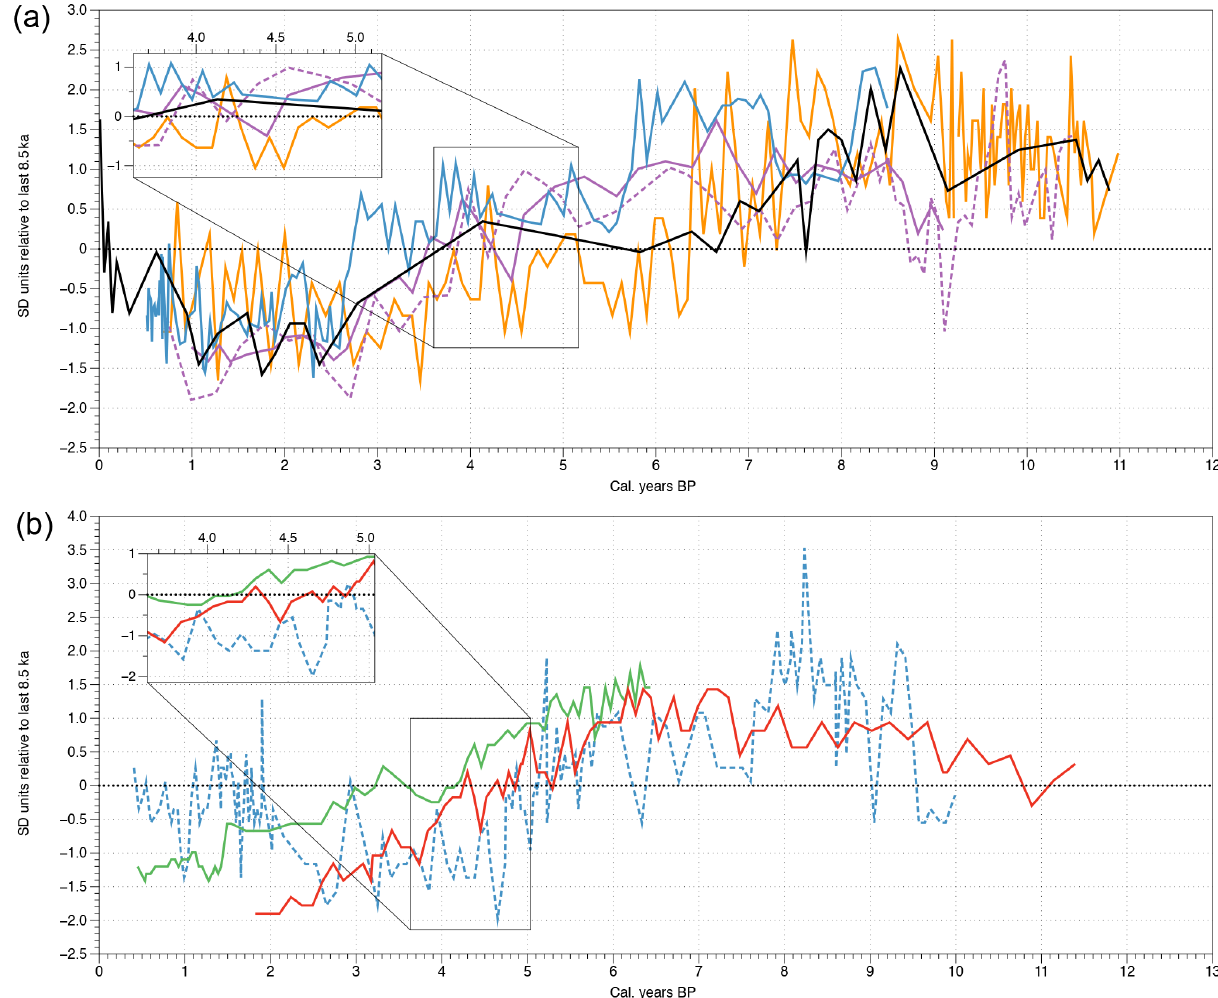
Figure 2. Alkenone-based paleo SST estimates from North Atlantic sites (shown in Fig. 1). (1) Black – Risebrobakken et al. (2010): core PSh-5159N; 71.35 ◦ N, 22.63 ◦ E. (2) Purple – Marchal et al. (2002): core M23258-2; 75 ◦ N, 13.97 ◦ E. (3) Dashed purple – Rigual-Hernández et al. (2017): core SV-04; 74.957 ◦ N, 13.899 ◦ E. (4) Orange – Marchal et al. (2002): core MD95-2015; 58.76 ◦ N, 25.958 ◦ W. (5) Blue – Calvo et al. (2002): core MD95-2011; 66.97 ◦ N, 7.633 ◦ E. (6) Red – Emeis et al. (2003): core IOW 22517; 57.67 ◦ N, 7.091 ◦ E. (7) Green – Emeis et al. (2003): core IOW 22514; 57.84 ◦ N, 8.704 ◦ E. (8) Dashed blue – Kristiánsdóttir et al. (2017): core MD2269; 66.63 ◦ N, 20.85 ◦